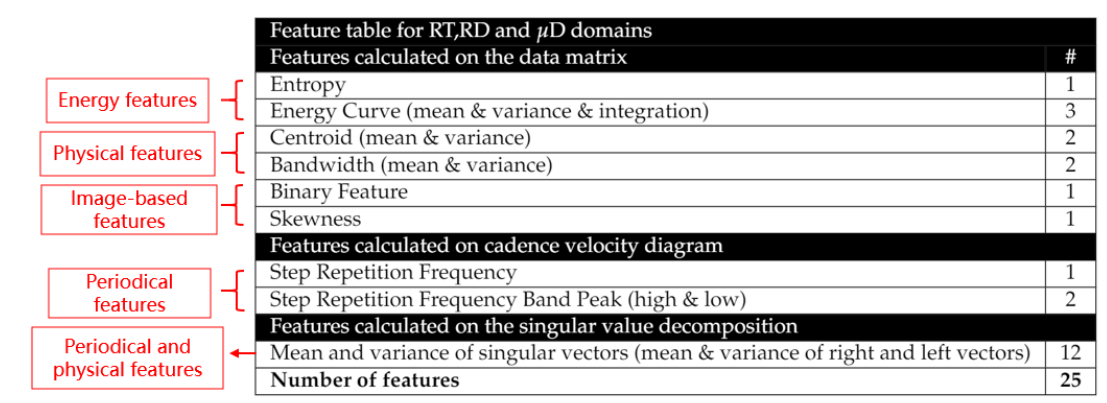
Table 1. List of the features extracted for activity